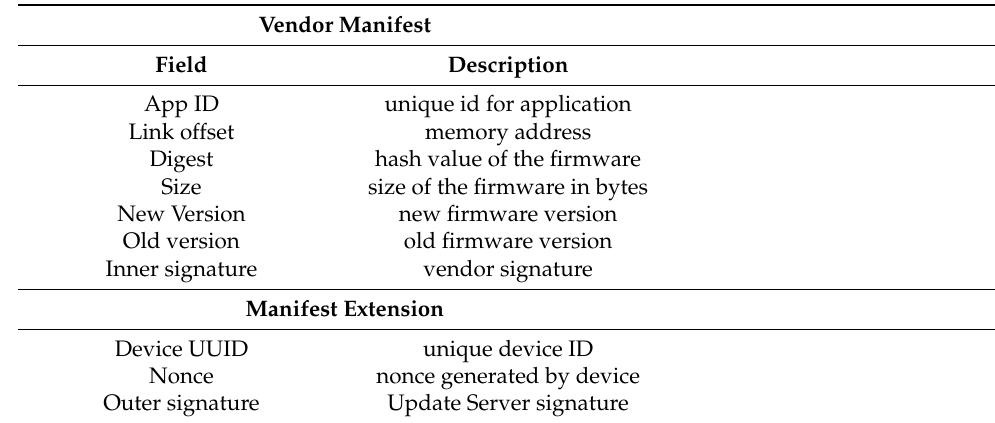
Figure 2. MYNO update protocol as a sequence diagram. Table 1.